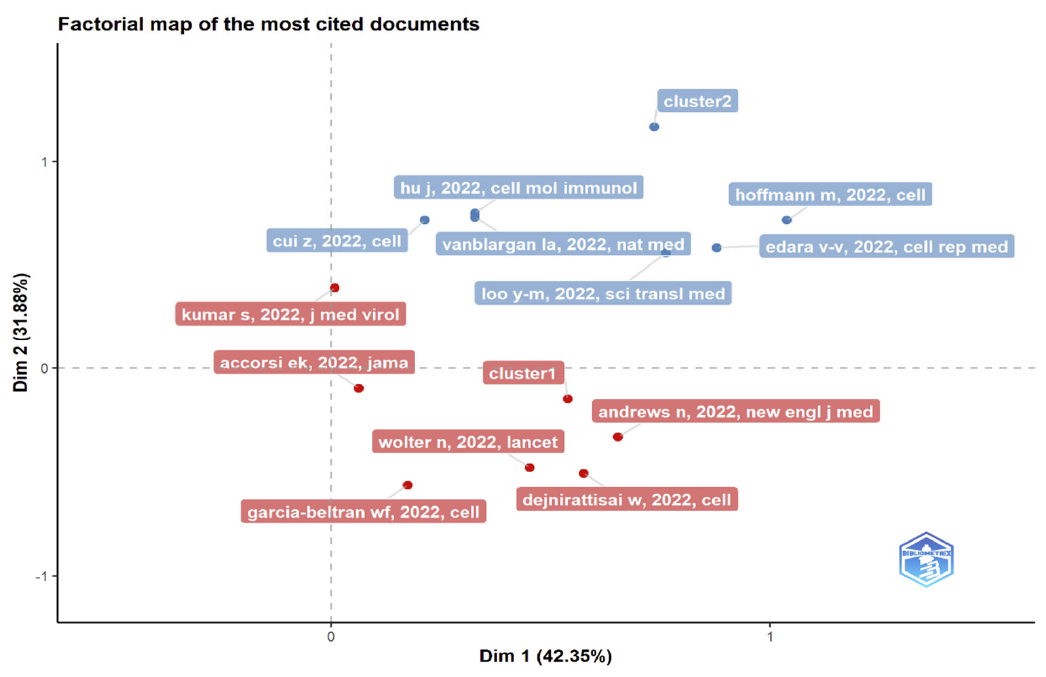
Figure 15. Factorial map using multiple correspondence analysis of the most cited documents related to Omicron-based research.